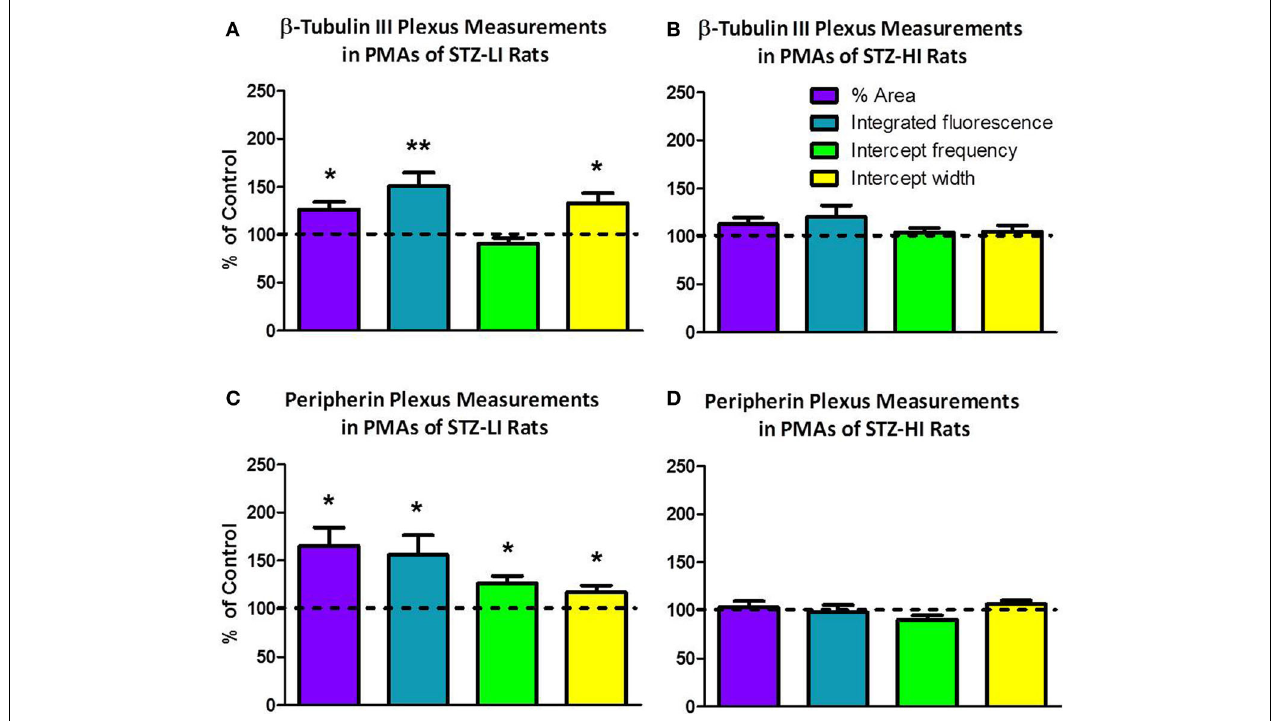
FIGURE 4 | The percent area of the vessel surface covered by the immunolabeled nerve plexus (% area), integrated fluorescence/100 μ m 2 of vessel surface (integrated fluorescence), and the frequency and width of intercepts along line profiles of plantar metatarsal arteries (PMAs) immunolabeled for β -tubulin III (A,B) and peripherin (C,D) from streptozotocin (STZ)-treated rats that received a low (STZ-LI; A,C) or a high (STZ-HI; B,D) dose of insulin. All these measures are expressed as a percentage of those in paired control tissues (i.e., terminated on the same day). Relative to the controls, the β -tubulin